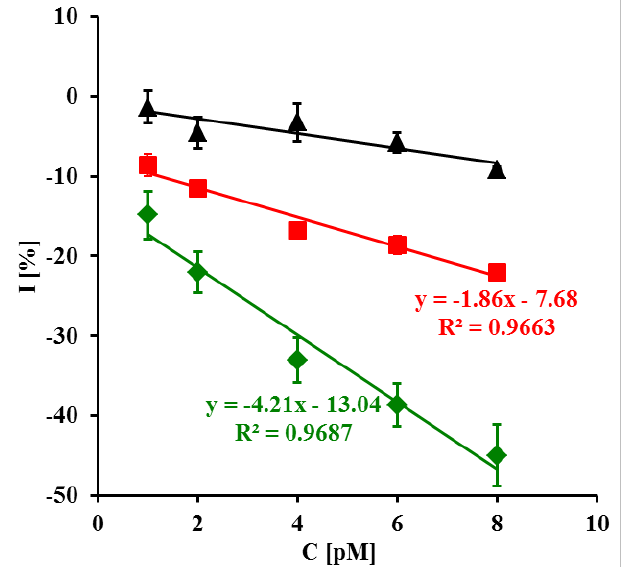
Figure 4. The relationship of I = (I ( ▲ ) PC. I is the value of peak current after detection of given target concentration, and I n is the value of peak current without presence of target in pure 0.1 M PBS, pH 7.4 (n =